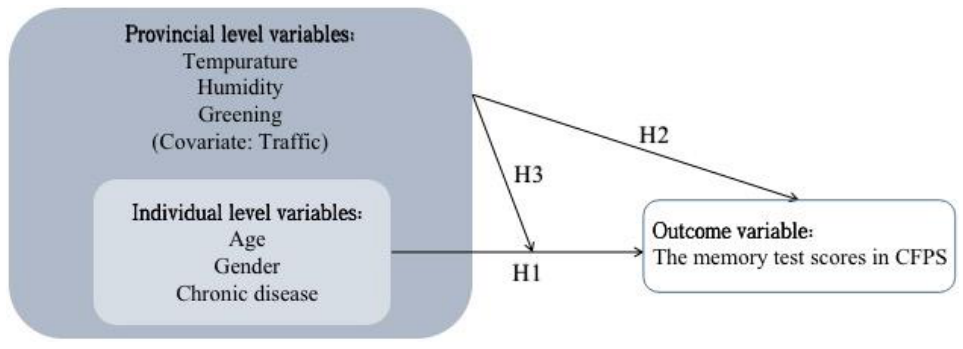
Figure 1. The proposed multilevel model.